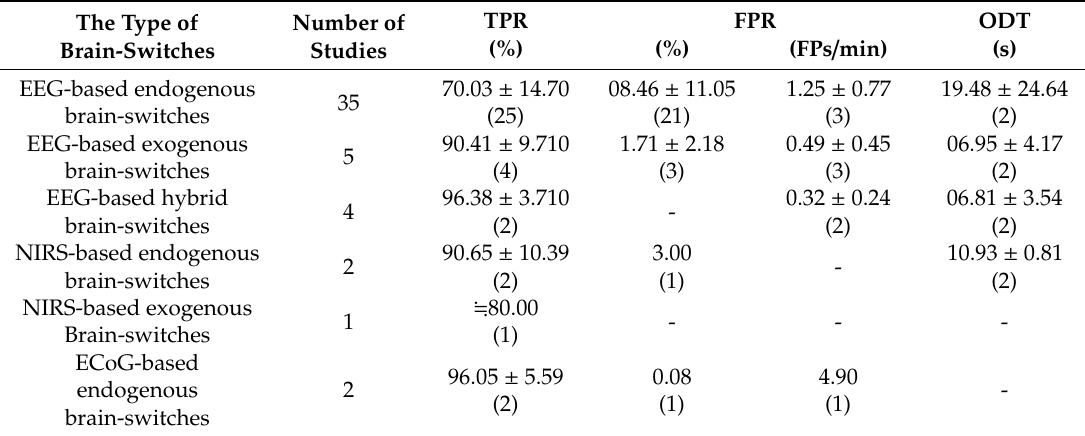
Table 8. Overall performances of each brain-switch approach. Note that the means and standard deviations are calculated based on studies reporting corresponding performance metrics, and the numbers of studies used to calculate each performance metric are provided in